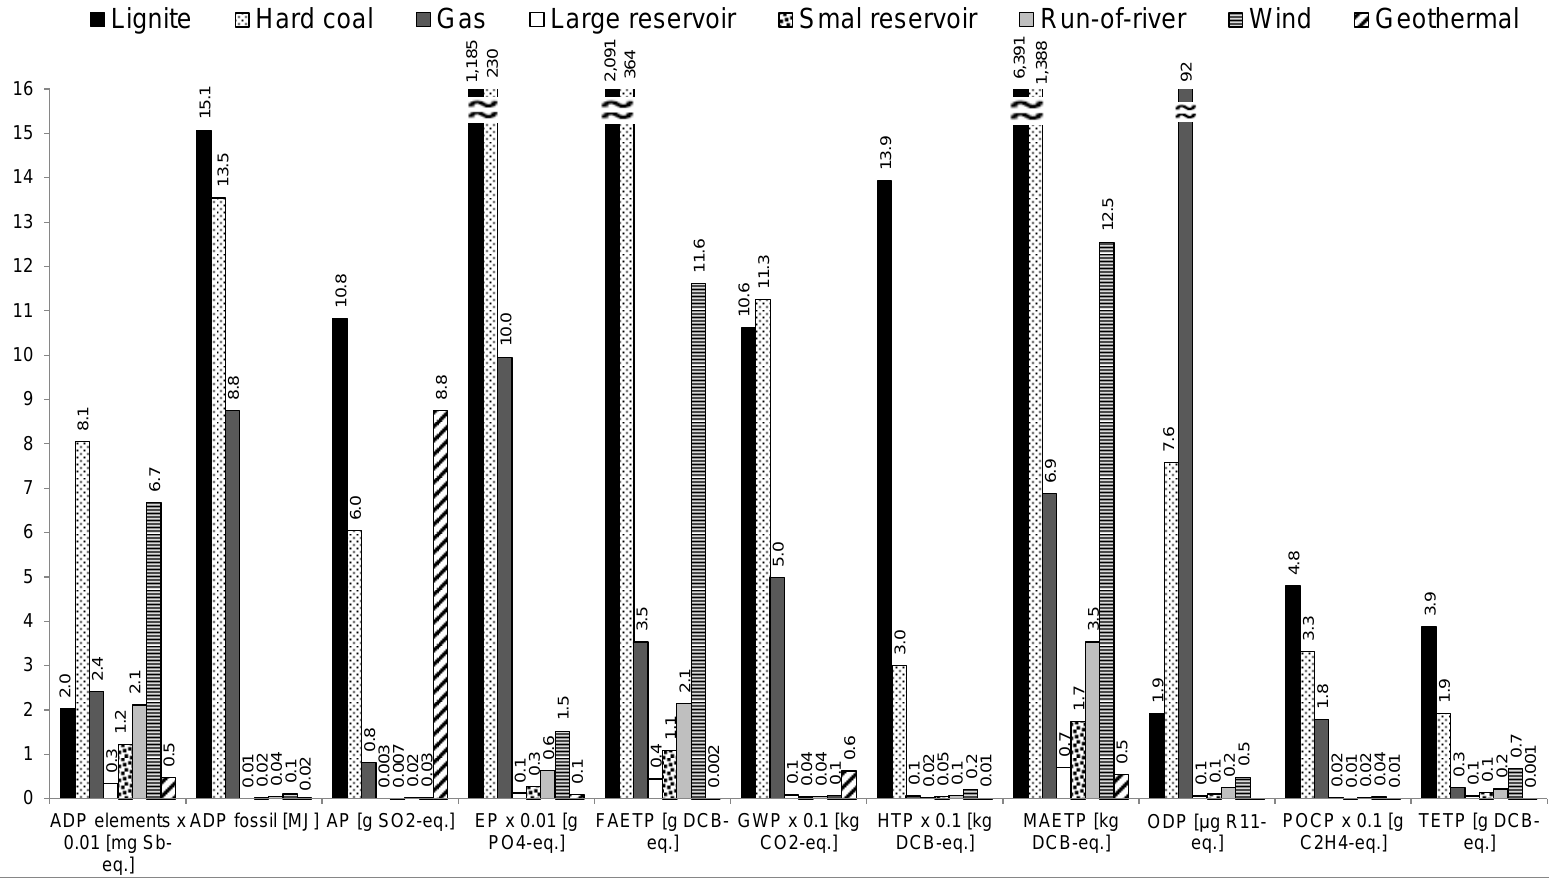
Figure 3. Environmental impacts for different electricity options in Turkey. [All impacts expressed per kWh of electricity generated. The values shown on top of each bar represent the total impact after the recycling credits for the plant construction materials have been taken into account. Some values have been rounded off and may not correspond exactly to those quoted in the text. ADP: Abiotic depletion of elements; ADP fossil: Abiotic depletion of fossil; AP: Acidification potential; EP: Eutrophication potential; FAETP: Fresh water aquatic ecotoxicity potential; GWP: Global warming potential; HTP: Human toxicity potential; MAETP: Marine aquatic ecotoxicity potential; ODP: Ozone layer depletion potential; POCP: Photochemical oxidants creation potential; TETP: Terrestrial ecotoxicity potential.].